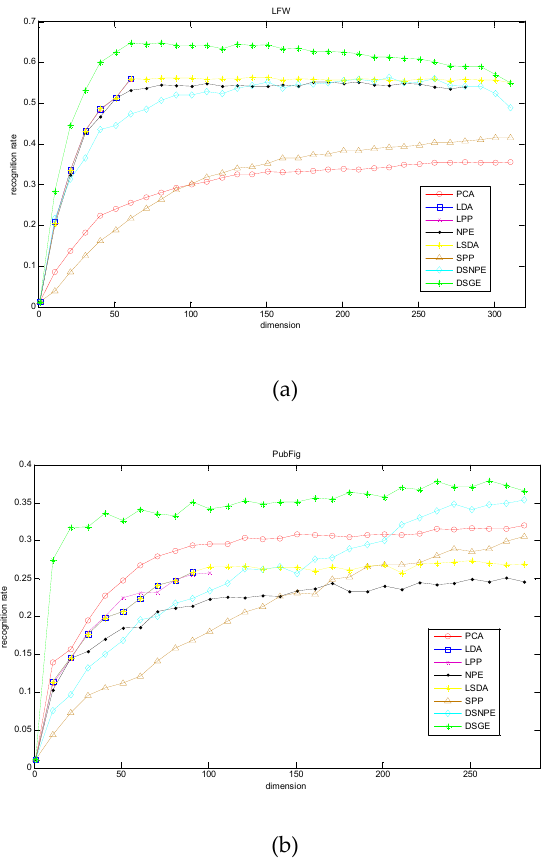
Figure 9. Recognition rate vs. variation of dimension on the LFW database and PubFig database. ( a ) LFW database; ( b ) PubFig database.